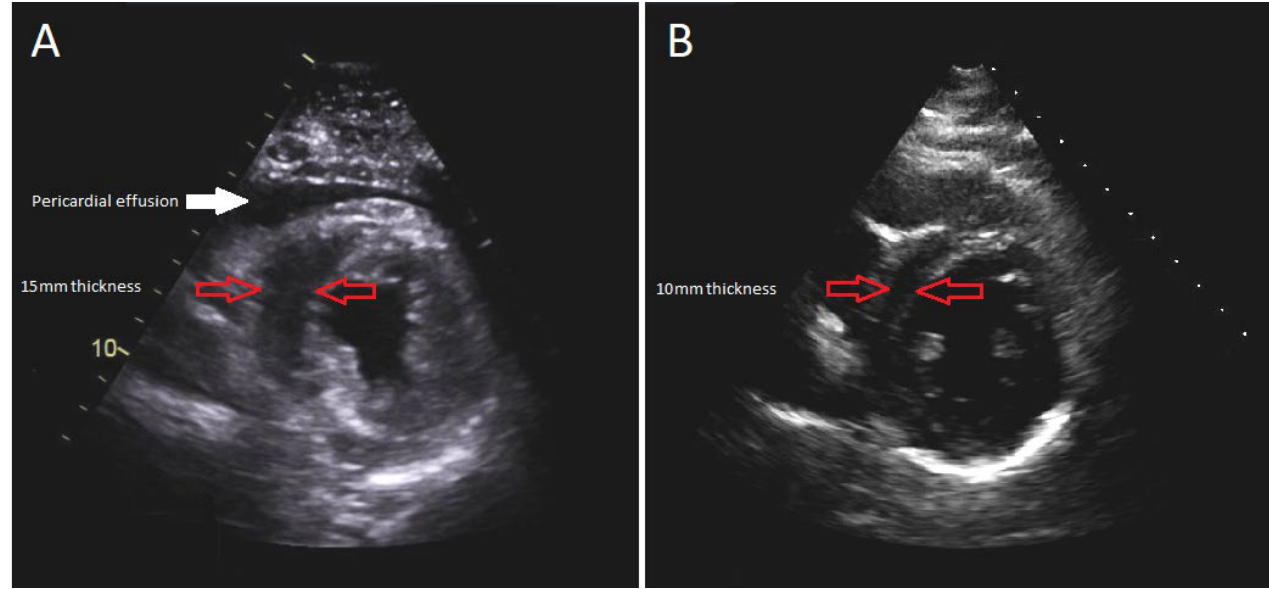
Figure 2. Parasternal short-axis view of TTE: ( A ) during the acute illness revealing 15 mm LV wall thickness; ( B ) 1-month follow-up demonstrating 10 mm LV wall thickness.